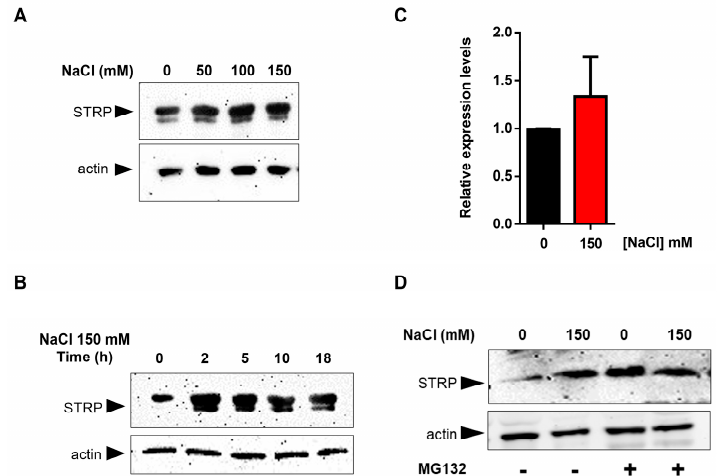
Figure 1. Salt stress increases STRP levels by inhibiting proteasome–mediated degradation of the protein. Salt Tolerance–Related Protein (STRP) levels were assessed by Western blot on two–week–old seedlings treated with 50, 100, and 150 mM NaCl for 18 h ( A ) or with 150 mM NaCl for 2, 5, 10, and 18 h ( B ). Twenty µ g of whole cellular extract were separated by SDS–Page, electroblotted on the PVDF membrane, and incubated with the anti-STRP antibodies. Actin was used as a loading control. ( C ) STRP expression levels under salt stress were determined by RT-qPCR on total RNA extracted from two-week-old A. thaliana seedlings treated with 150 mM NaCl for 18 h. Error bars are s.e.m. of three independent experiments. ( D ) MG132 treatment was performed on the whole cellular extract of two-week-old seedlings treated with 150 mM NaCl for 18 h. Samples (20 µg) were separated by SDS–Page, transferred on the PVDF membrane, and immunodecorated with anti-STRP and anti-actin antibodies as loading control.